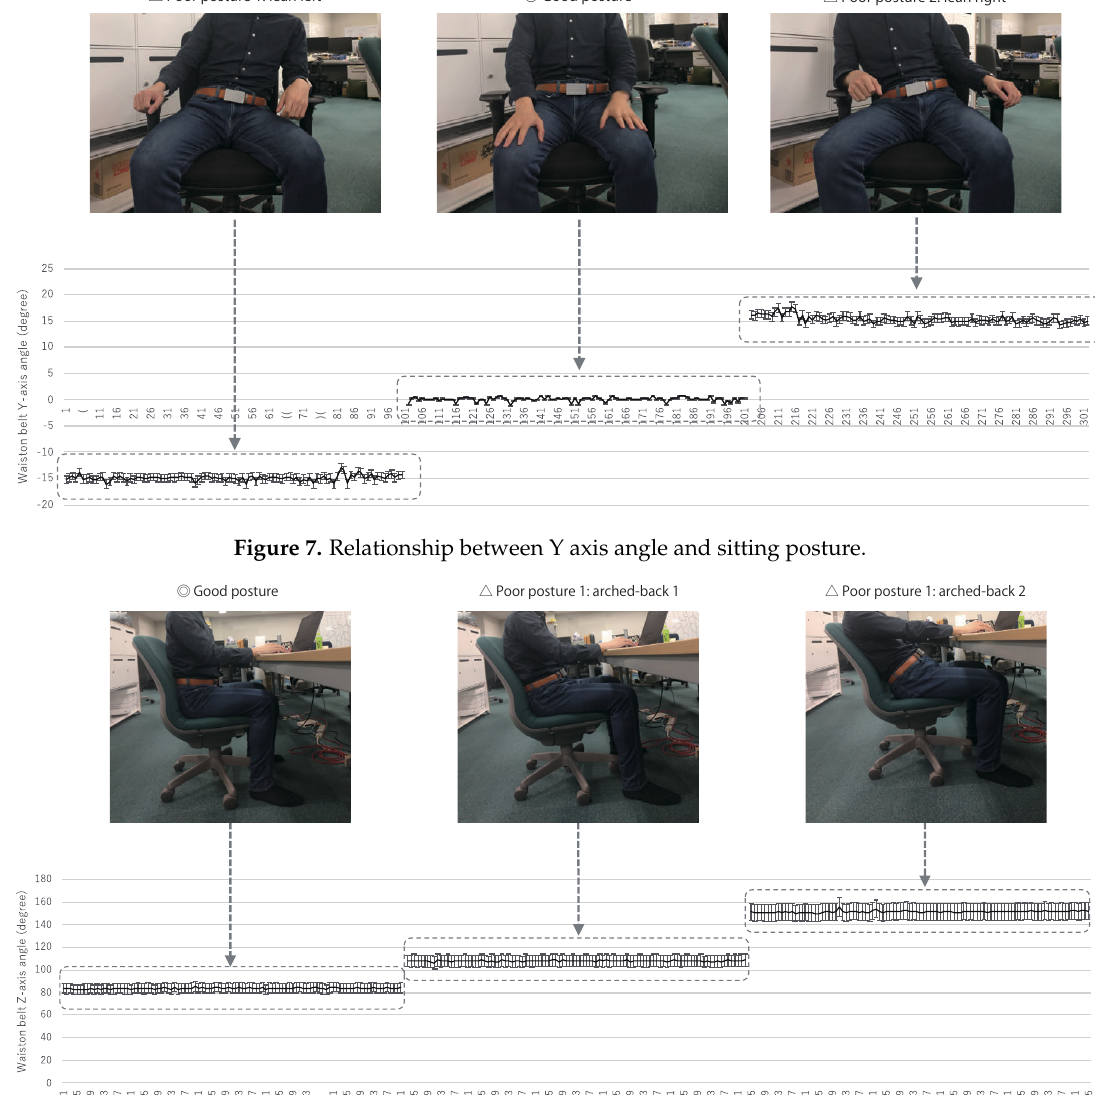
Figure 8. Relationship between Z axis angle and sitting